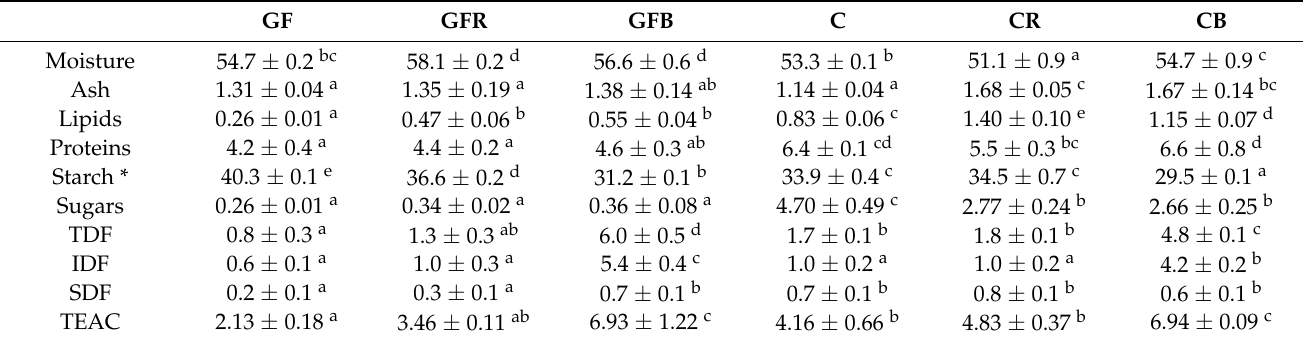
Table 1. Nutritional composition (g/100 g) and antioxidant capacity (mmol TEAC/kg) of raw gnocchi.